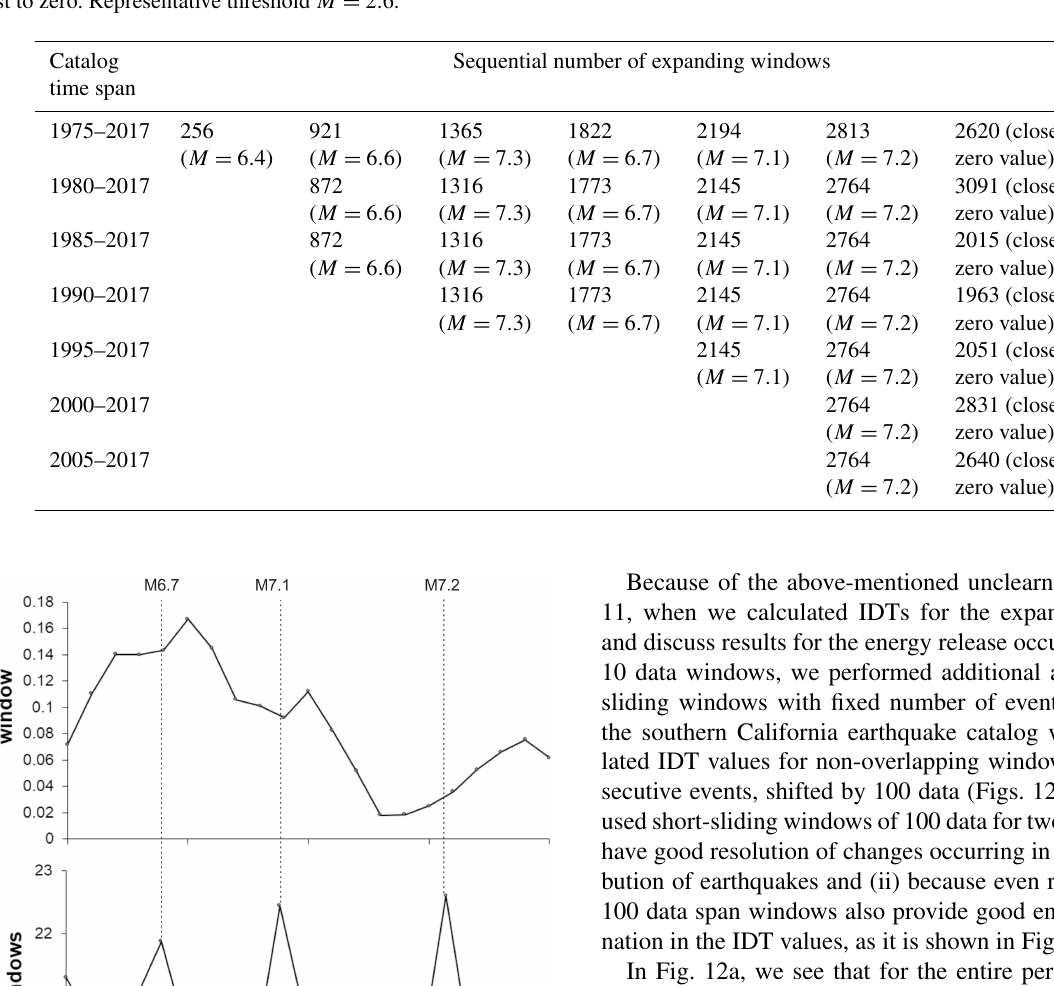
Table 1. Comparison between expanding by 10 data windows with the strongest earthquakes occurrences and windows with IDT values closest to zero. Representative threshold M = 2 . 6.